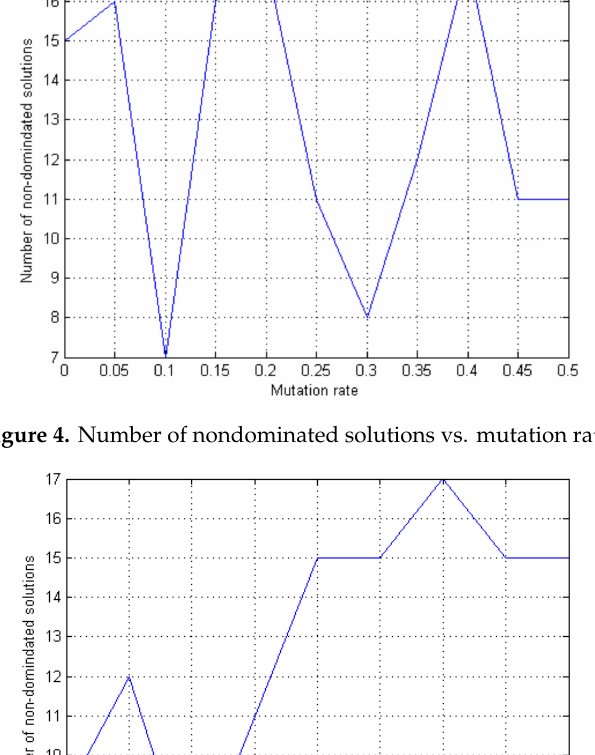
Figure 4. Number of nondominated solutions vs. mutation rate.